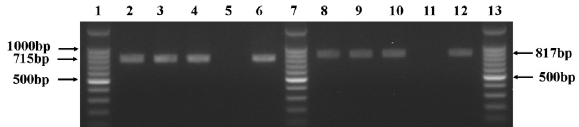
Figure 1. PCR amplification of the mitochondrial gene fragments (715 and 817 bp) from Kudoa septempunctata (in triplicate).